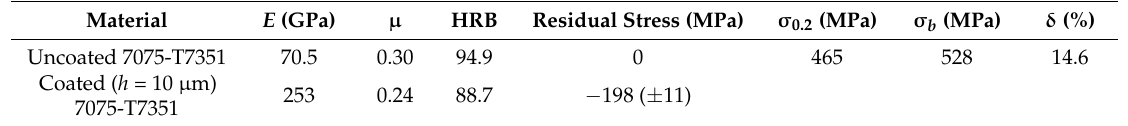
Table 1. Mechanical properties of samples ( E : Young (cid:48) s modulus, HRB: Rockwell